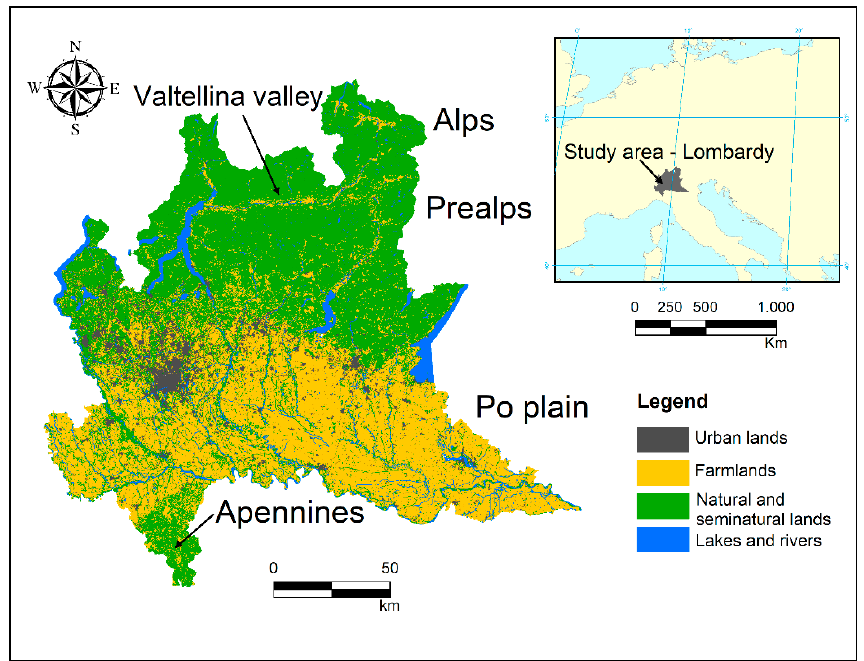
Figure 1. Study area. Land use refers to DUSAF 2018 digital map, level 1 of classification [55].